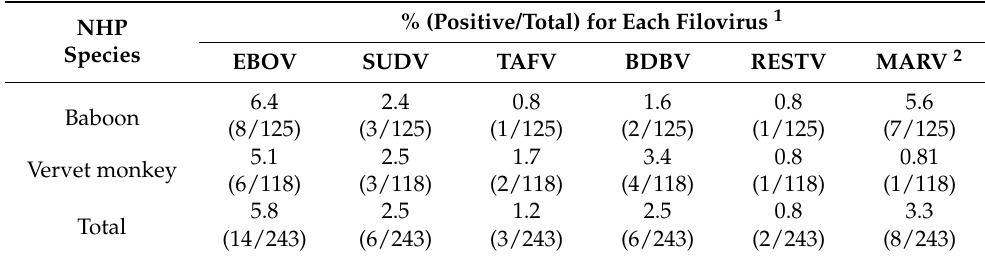
Table 3. Seropositive rates of baboons and vervet monkeys to each filovirus species. NHP